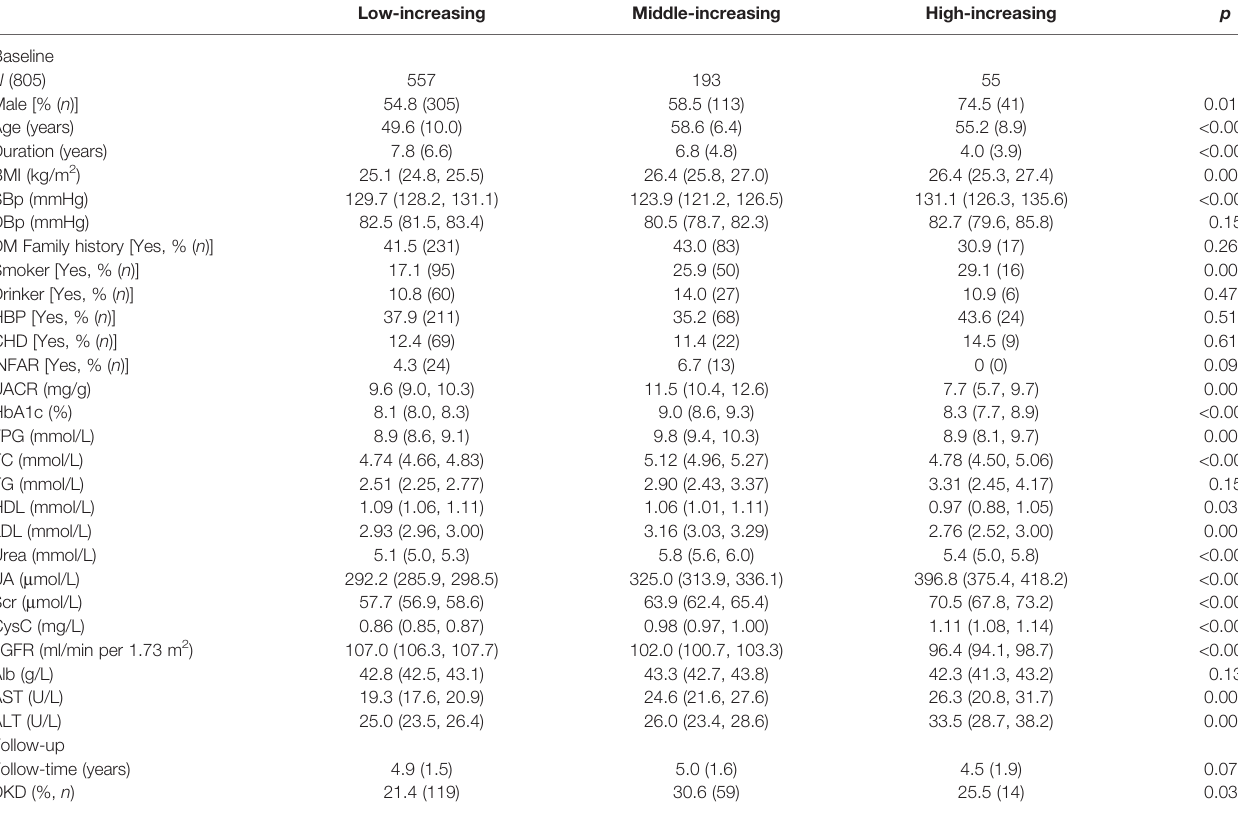
TABLE 3 | Baseline characteristics by serum Cysc latent classes. Low-increasing Middle-increasing